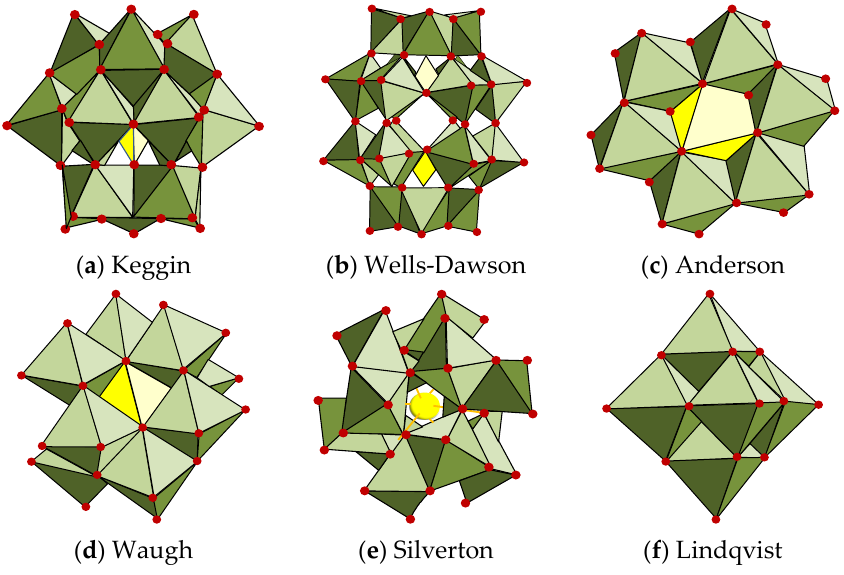
Figure 3. Polyoxometalates (POM) structures in polyhedral representations. Adapted from Ref. [15], Copyright 2013, Elsevier.